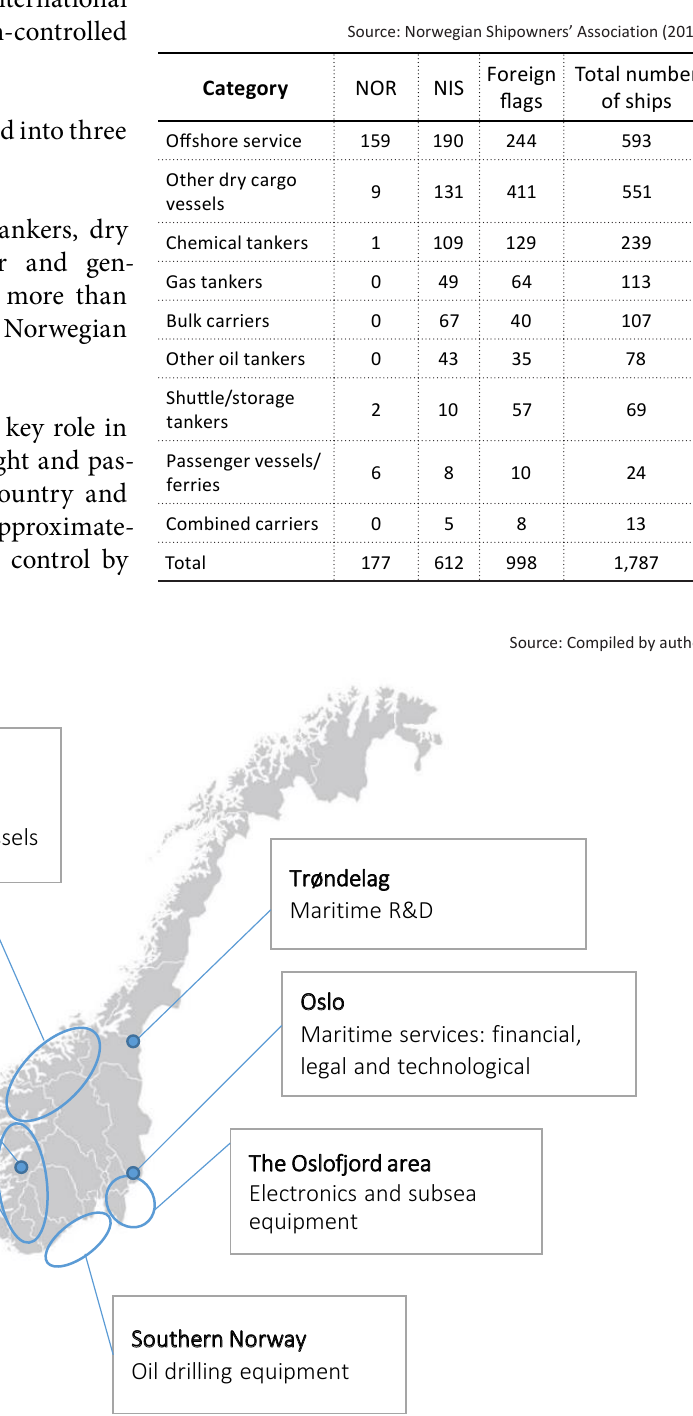
Figure 1. Geographical distribution of the most important maritime regions in